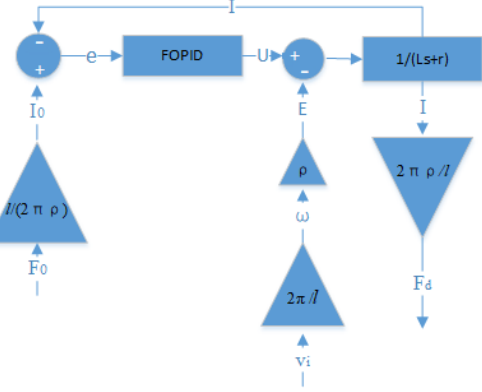
Figure 7. Equivalent circuit diagram of the energy regenerative motor .